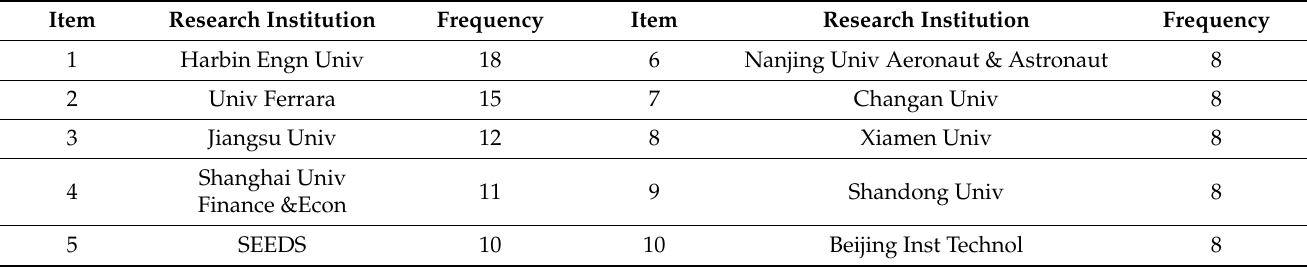
Figure 5. CiteSpace-based mapping of institutional collaboration. Table 4. Number of papers issued by TOP 10 research institutions.